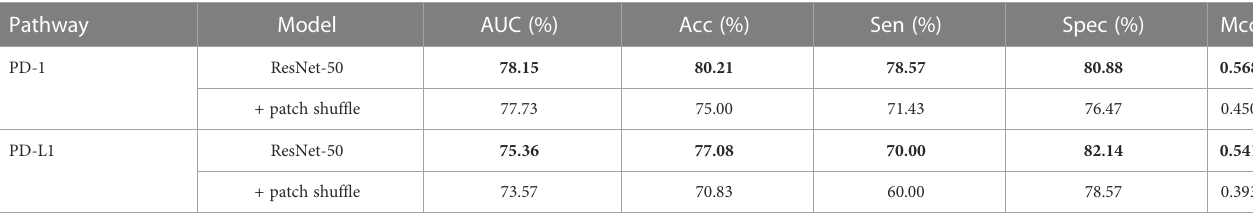
TABLE 6 Performance comparison between the supervised ResNet-50 with and without patch shuf fl e strategy. Pathway